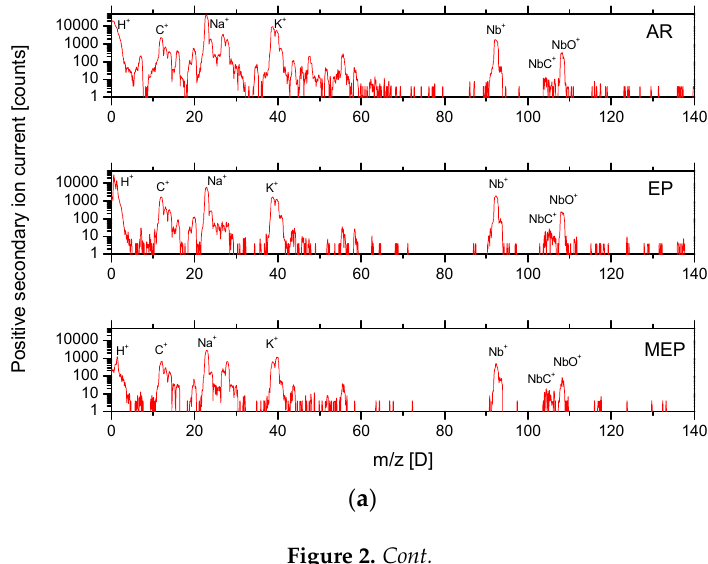
Table 1. Parameters used in the Secondary Ion Mass Spectrometry (SIMS) studies.